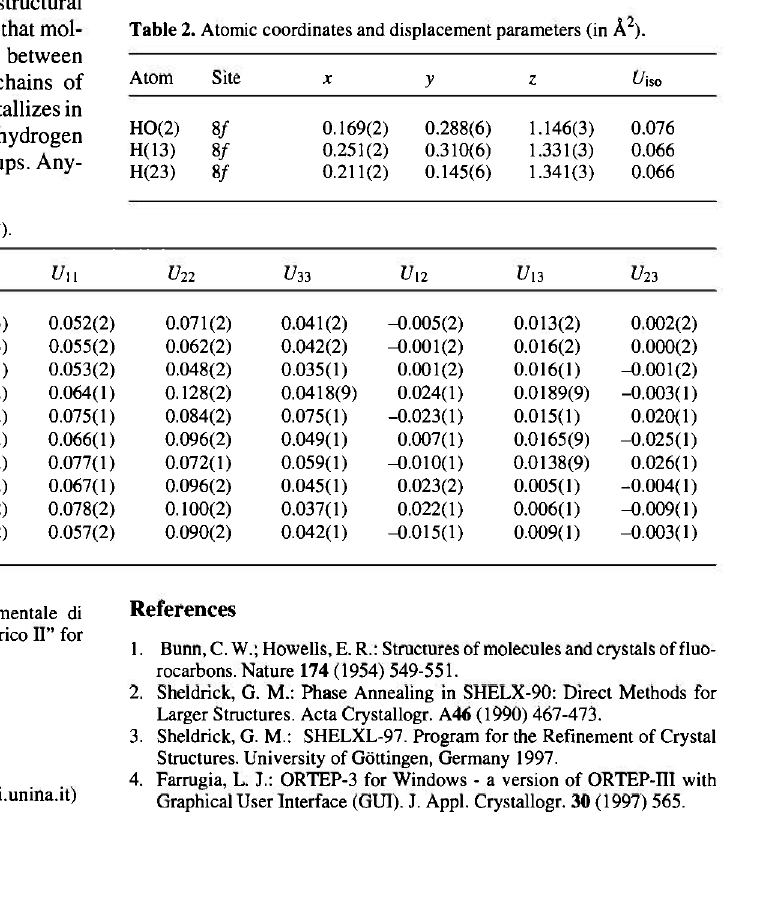
Table 1. Data collection and handling. Crystal: